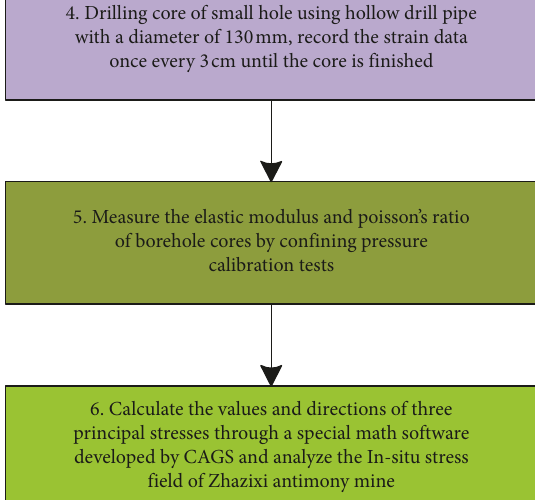
Figure 5: The block diagram of borehole stress relief method.